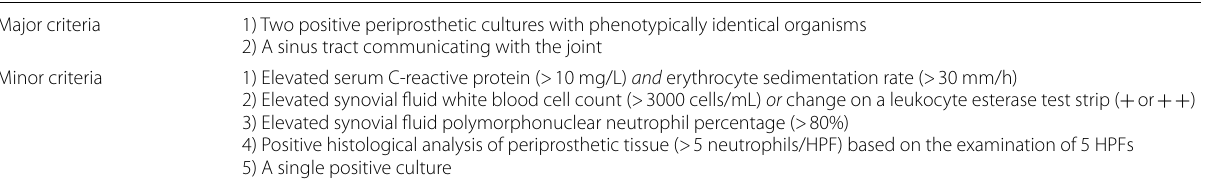
Table 1 MSIS criteria a Major